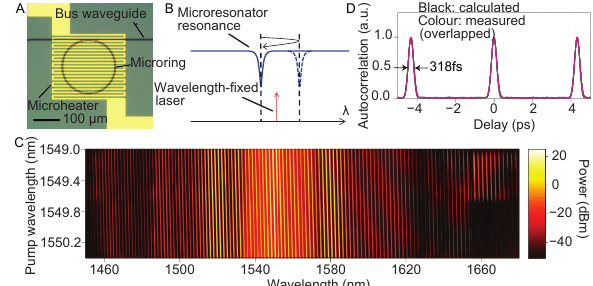
Figure 21: Microheater-actuated comb generation and tuning. (A) Microscope image of a Si 3 N 4 microring integrated with a micro- heater. The ring radius is 100 µm. (B) Illustration of comb gener- ation by tuning the resonance. (C) Comb spectra with the center wavelength tuned from 1549.0 to 1550.4 nm with an increment of 0.1 nm. The comb line spacing is ~231 GHz. (D) Autocorrelation traces for each comb in (C) after spectral line-by-line shaping.